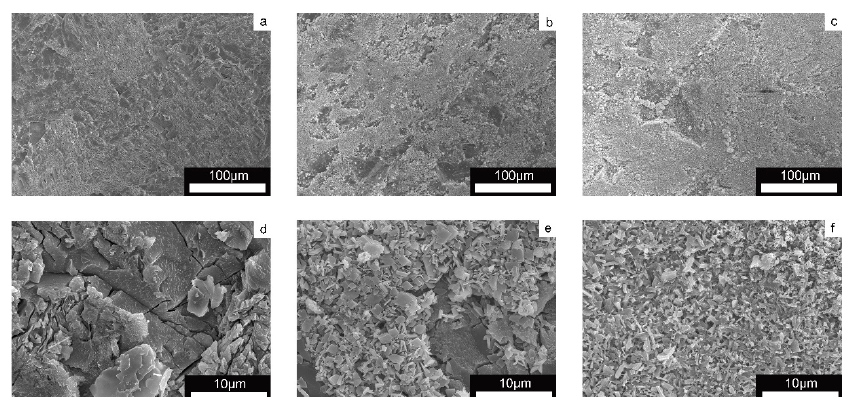
Figure 10. SEM images after UT ( a , d ), AO ( b , e ) and 0.02 mol/L CA ( c , f ) were treated with 750 mL acid solution (HNO 3 :H 2 SO 4 = 1:1), with an initial pH of 4.0.